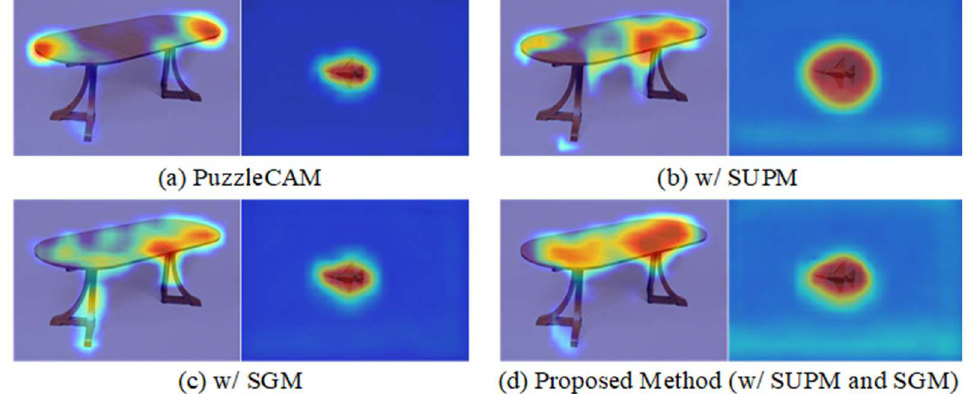
Figure 4. Ablation test with ResNet50 as the backbone along with SUPM and SMGM on PASCAL VOC2012 training dataset in CAM.